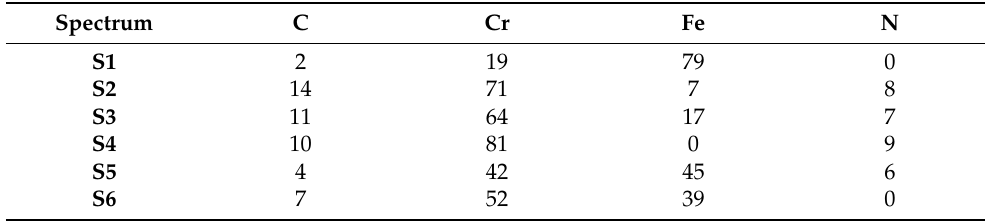
Table 4. Selected results of the EDS analysis of the points S1–S6 in Figure 8b, wt% assumed with relative scatter of ±